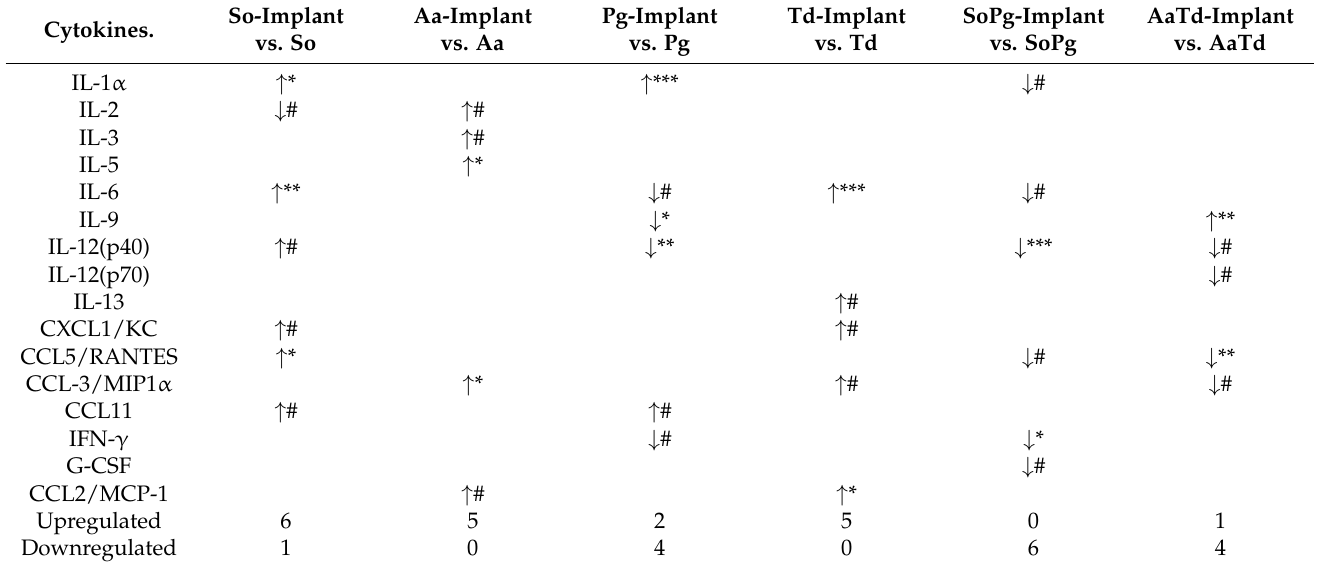
Table 2. Presence of implant material that play an important role in the systemic induction of inflammatory cytokines upon single or dual species infections. Symbols ***, **, *, and # indicate p < 0.001, p < 0.01, p < 0.05, and significant p -value prior to Bonferroni correction, respectively. ( ↑ ) indicate increase in the expression of cytokines, ( ↓ ) indicate decrease in the expression of cytokines.